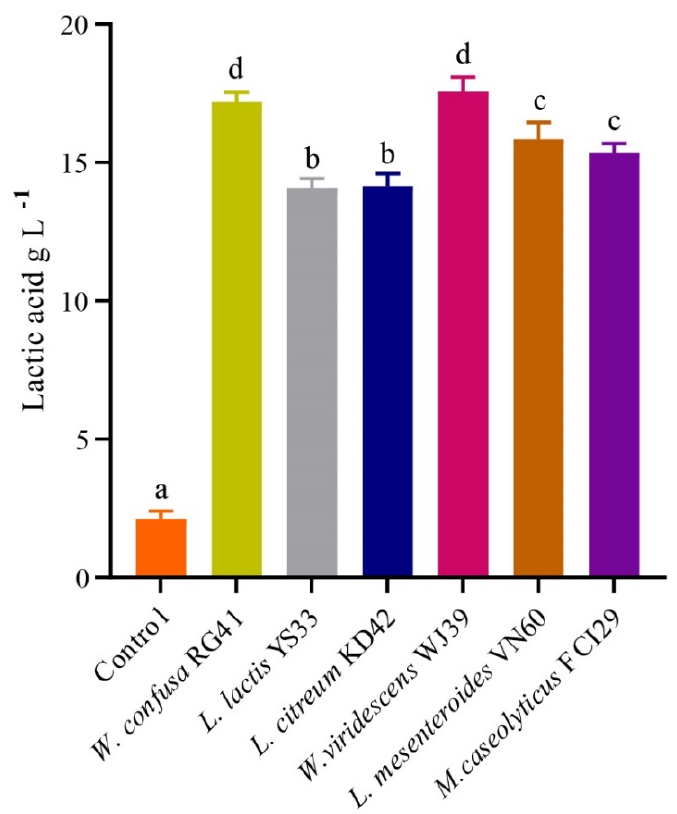
Figure 5. LA production potential of the bacteria at 24 h. The different letters denote a significant difference in the amount of LA production according to Duncan’s test ( p < 0.05).